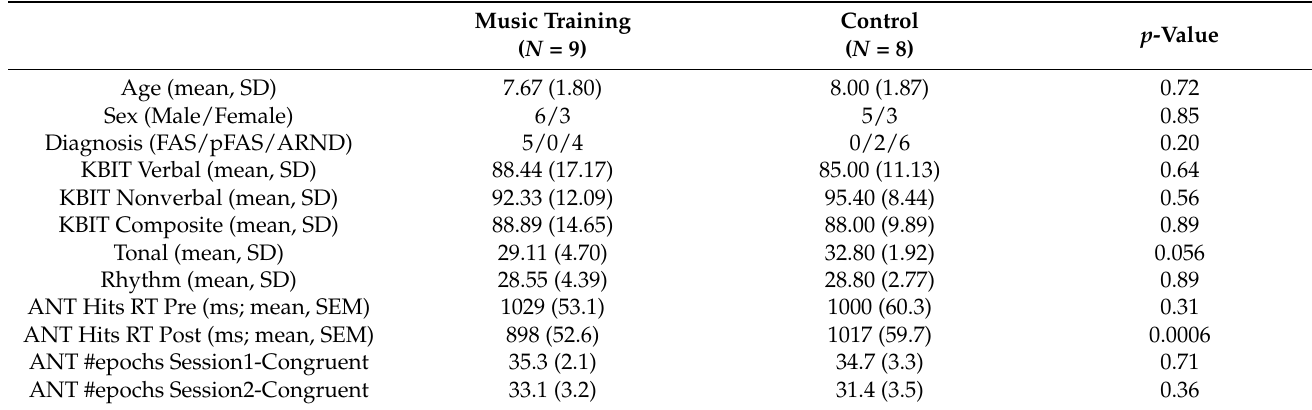
Table 1. Demographic characteristics.